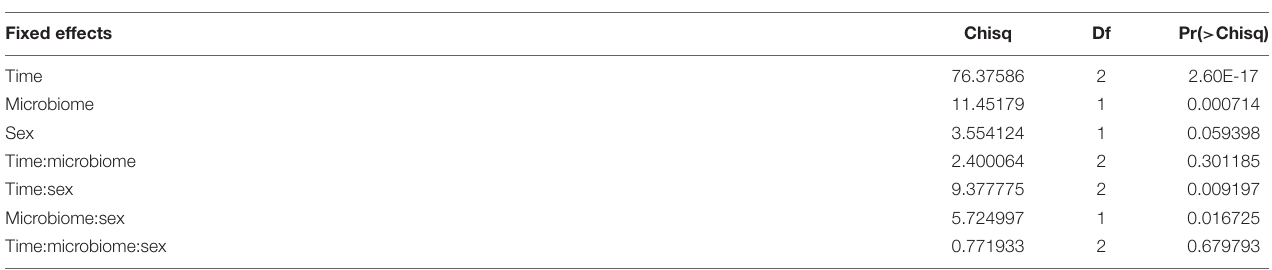
TABLE 1 | Summary of the GLMM/LMM Wald chi-square tests